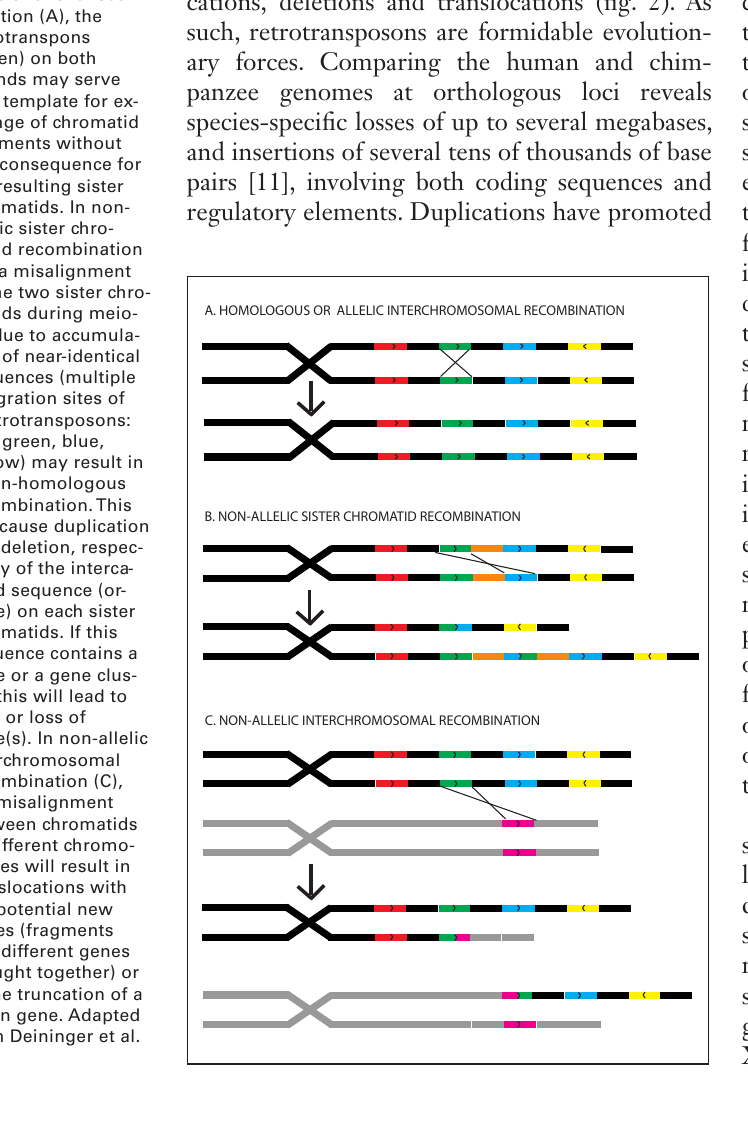
Figure 2 Examples of struc- tural sequence alterations caused by